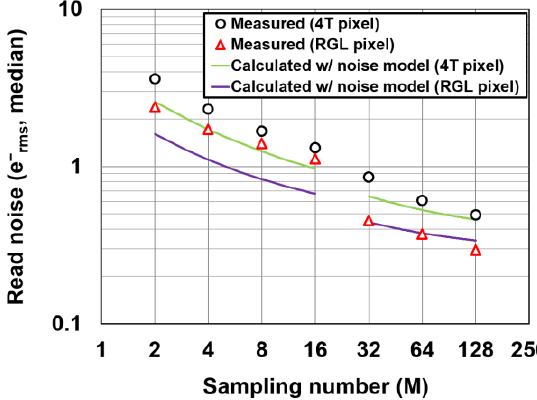
Figure 12. Column analog CDS and ADC circuits.